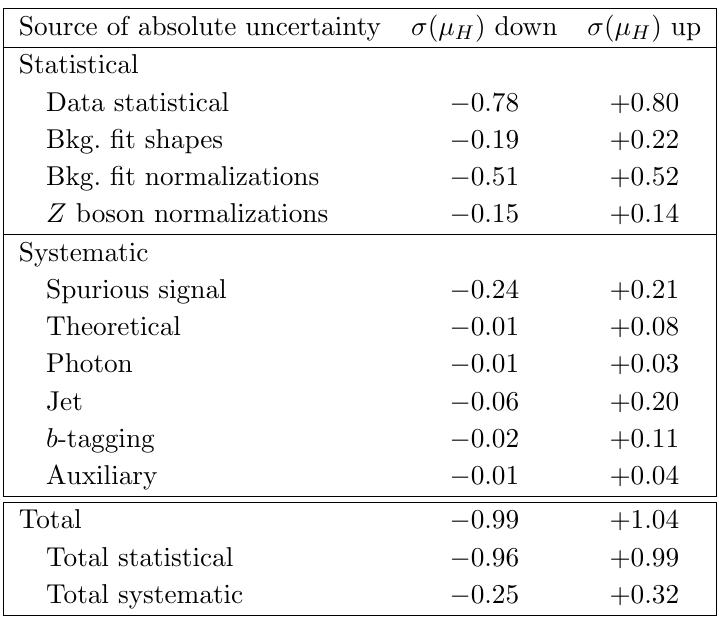
Table 3 . The e(cid:11)ect of the uncertainties on the signal strength. The dominant contributions are from the statistical uncertainty of the dataset, background (cid:12)t uncertainties, and the spurious-signal uncertainty. The statistical uncertainty is calculated by (cid:12)xing the background (cid:12)t parameters to their nominal values. Individual uncertainties are then combined to give the total within each group. The small uncertainties from pile-up e(cid:11)ects, luminosity measurements, and trigger scale factors are grouped under ‘Auxiliary’